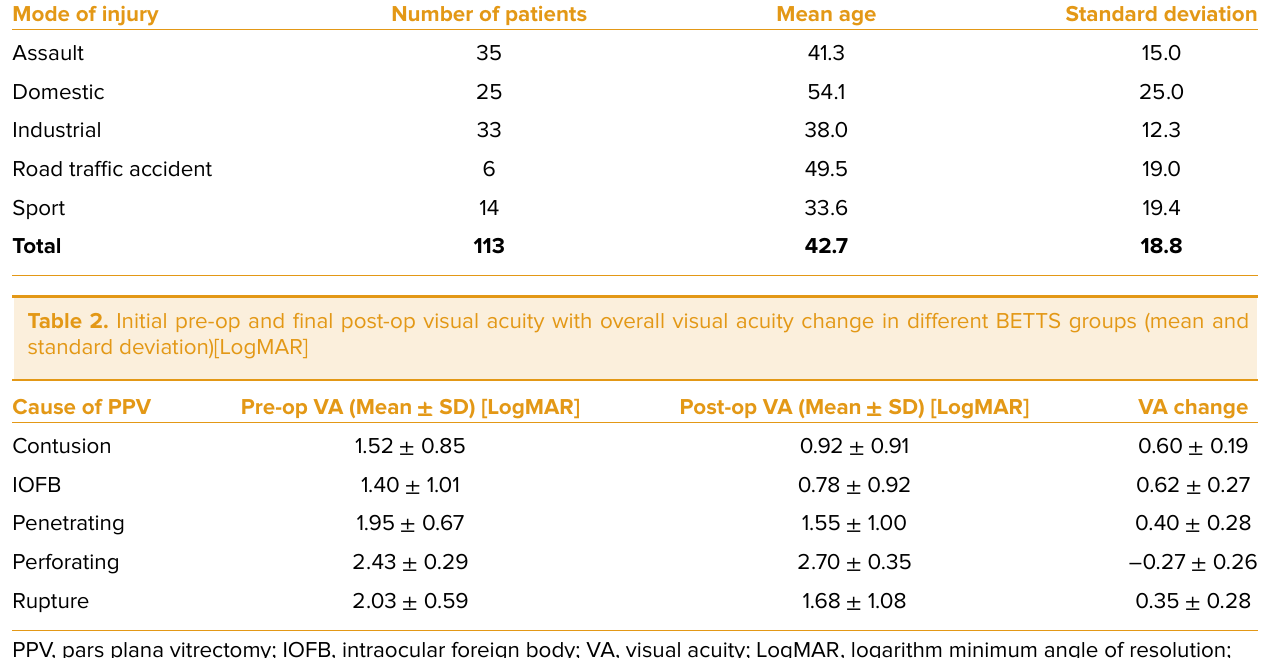
Table 1. Demographics showing number of patients and age (mean and standard deviation) for each mode of injury Mode of injury